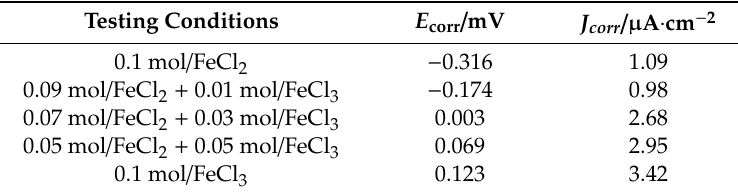
Table 2. Fitting values for polarization curves of 304 SS in 0.1 mol / L iron ion solution with di ff erent proportion of Fe 3 + .